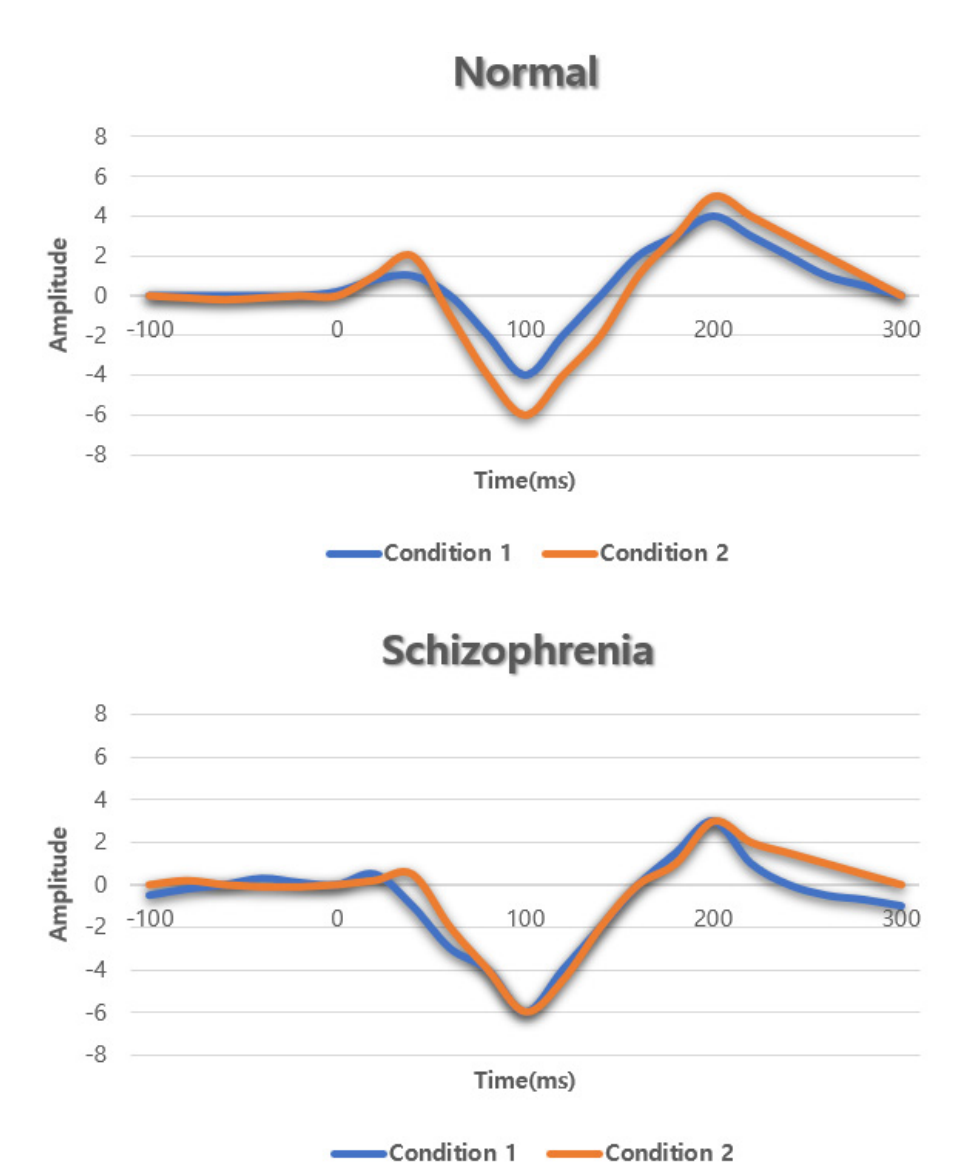
Figure 1. Differences in N100 EEG between schizophrenic patients and healthy.